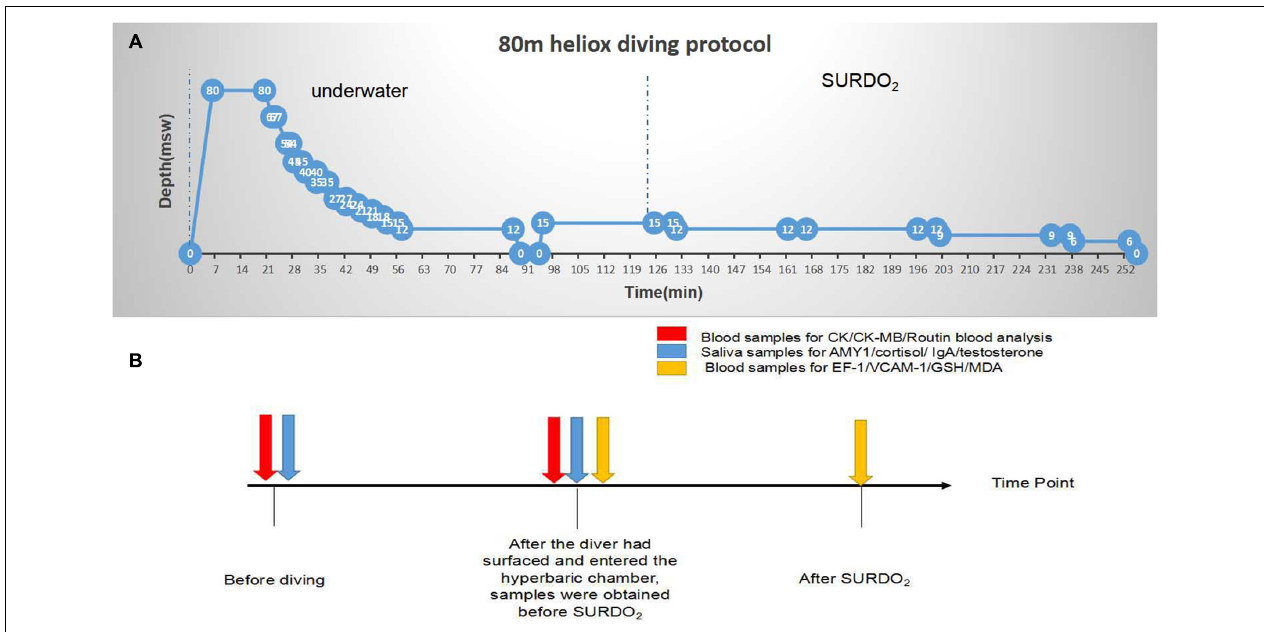
FIGURE 1 | Decompression procedure for 80 m heliox diving and sampling collection time points. (A) Decompression procedure for 80 m heliox diving. After blood and saliva collection, divers immersed to 80 msw at a rate of 12 msw/s, breathing air to heliox (He:O 2 , 82:18) with KMB 28B surface-supplied diving equipment. The bottom time was 15 min, and divers returned to the first stop station (67 msw) at an ascending velocity of 6 msw/min. After converting their breathing gas from heliox to air at 45 msw, divers ascended to 12 msw following the decompression table. After inhaling oxygen for 30 min at the 12 msw stop station, divers returned to the surface in 6 min and completed surface decompression with oxygen in a hyperbaric oxygen chamber. At the end of the experiment, blood and saliva samples were collected, and blood cell numbers and biomarkers were assayed. (B) Sampling collection time